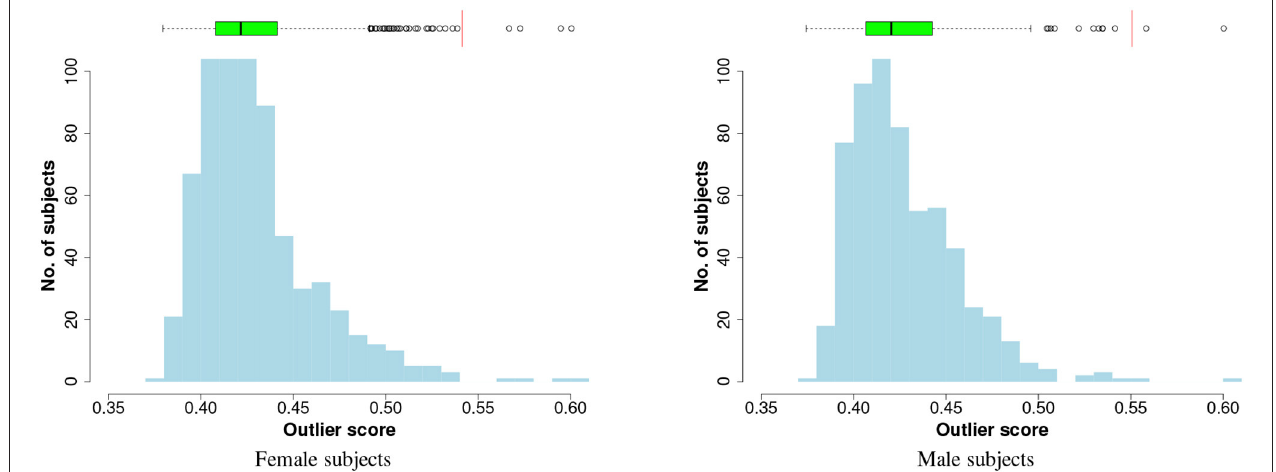
FIGURE 2 | Histogram and box plot of iForest outlier scores. The red vertical lines on the boxplots are the cutoff thresholds that identify four and two outliers, respectively, in female and male